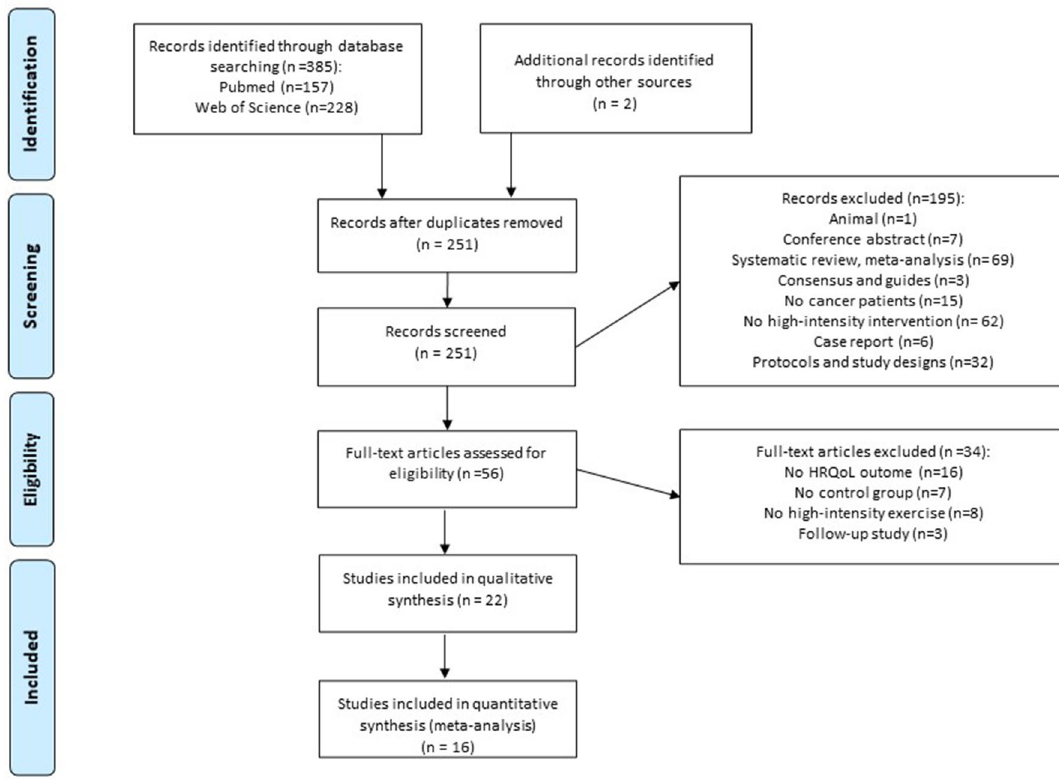
Figure 1. Study flow